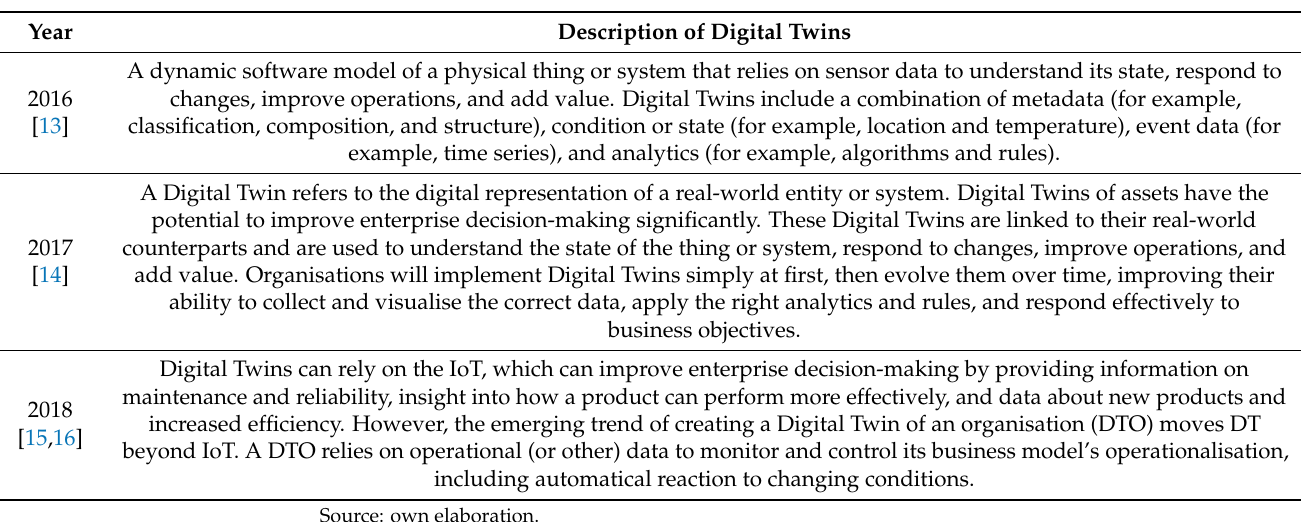
Table 1. Digital Twins as strategic technology trend from 2016–2019, by Gartner